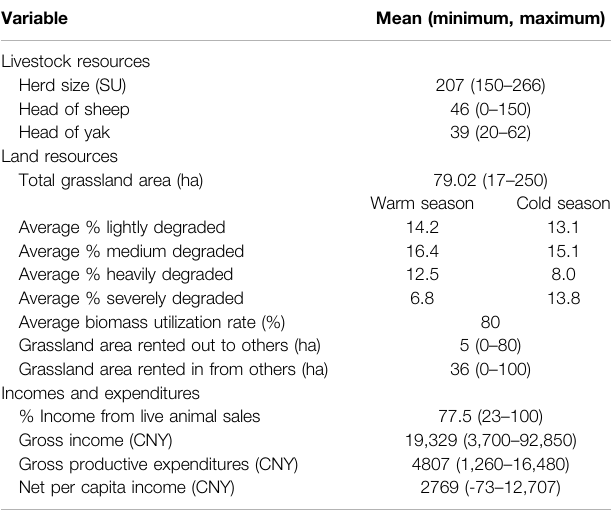
TABLE 3 | Key baseline characteristics of the household used for scenario modeling derived from household